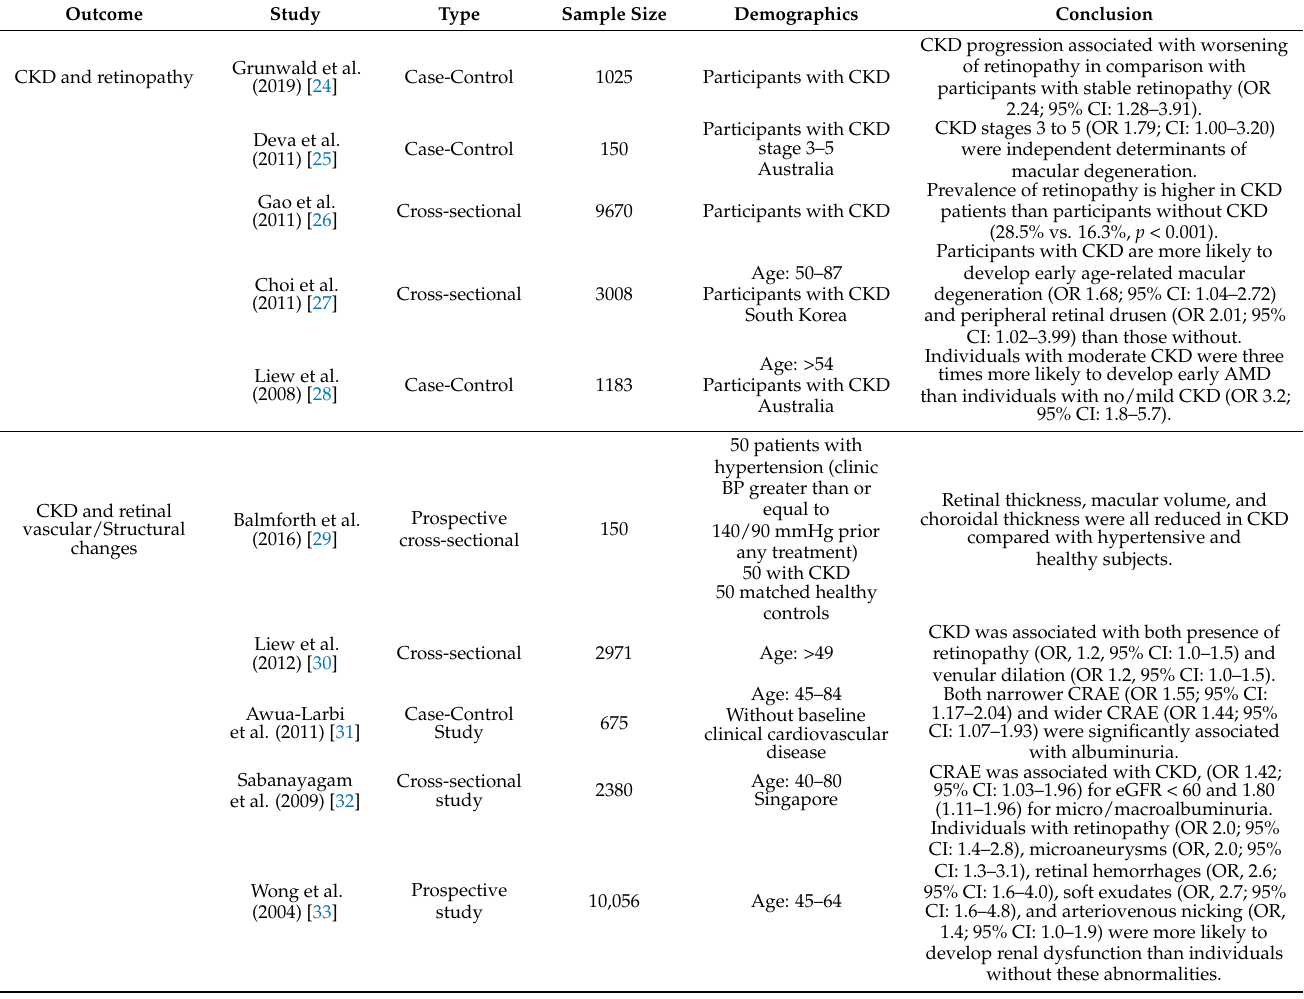
Table 3. Association of retinopathy and retinal vascular changes with CKD from population-based